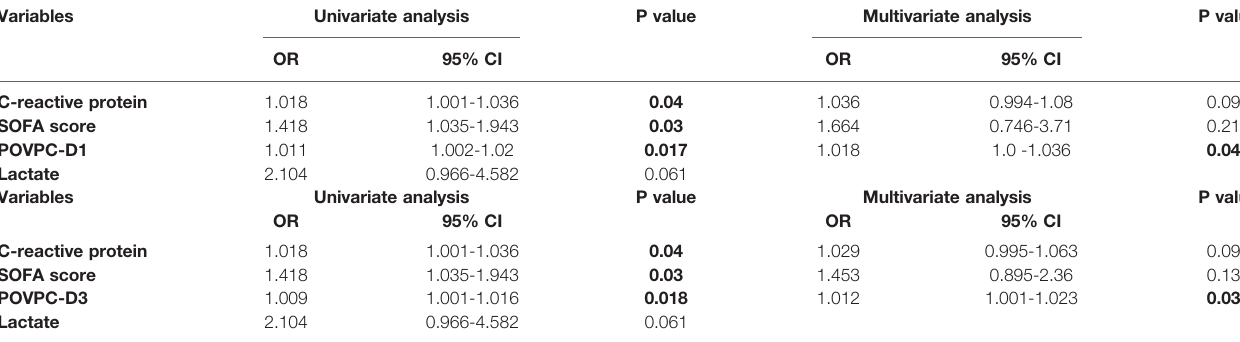
TABLE 6 | Univariate and multivariate logistic regression analysis of independent risk factors for 28-day mortality in septic patients.